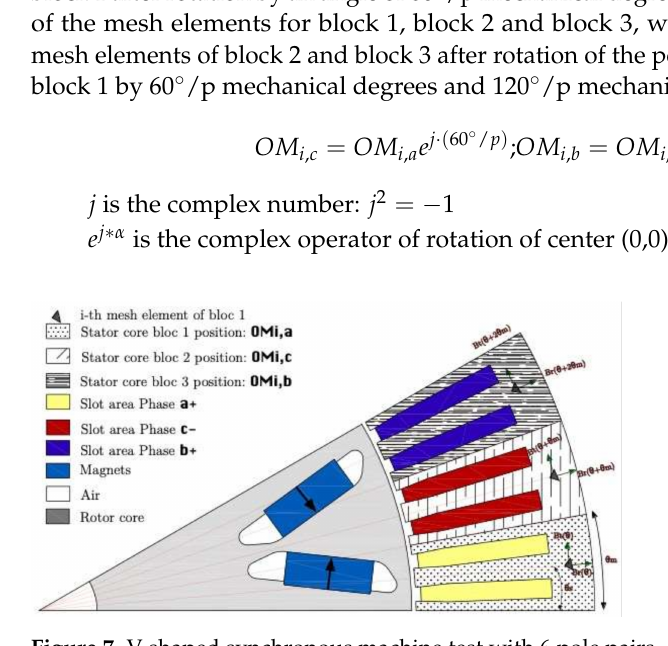
Figure 7. V-shaped synchronous machine test with 6 pole